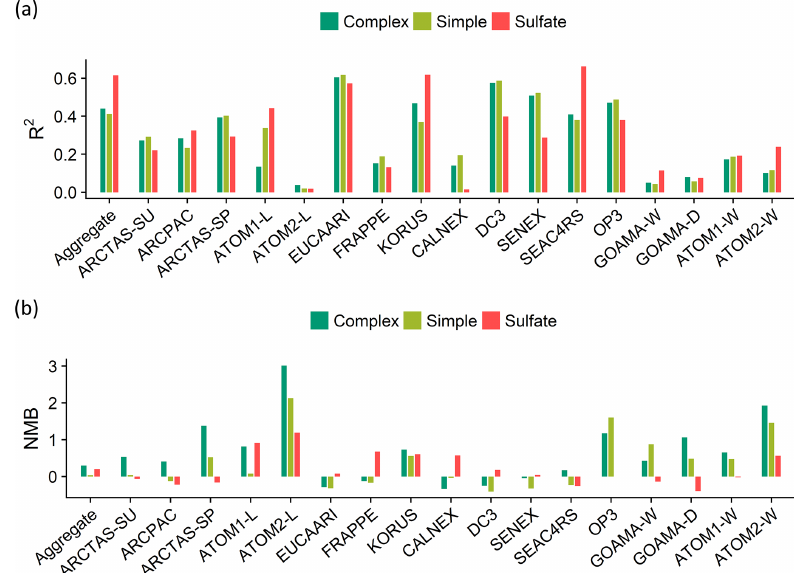
Figure 11. Statistical evaluation of the model skill against observations shown as (a) the coefficients of determination ( R 2 ) and (b) the normalized mean bias (NMB) across the individual field campaigns. The complex (dark green) and simple (light green) OA schemes are compared to the sulfate simulation